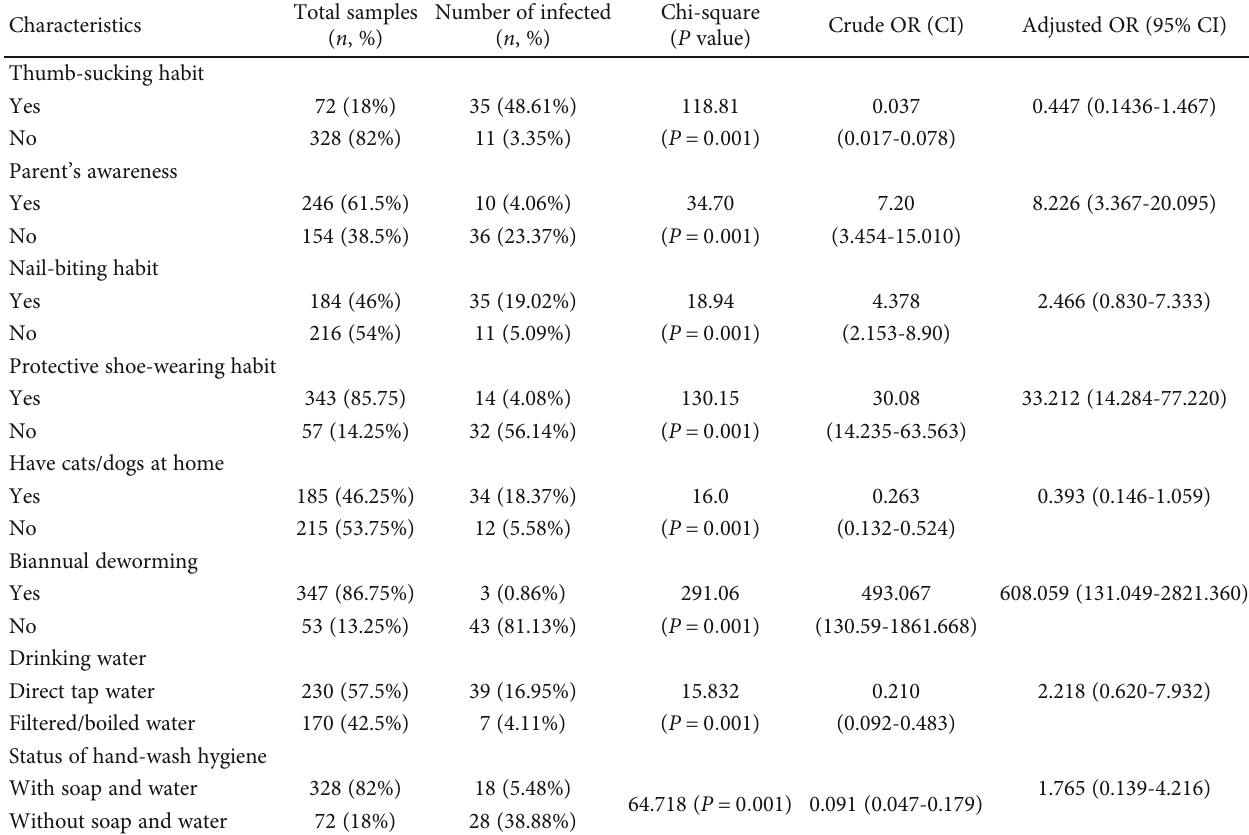
Table 5: Risk factors associated with infestation of intestinal parasitic infections.